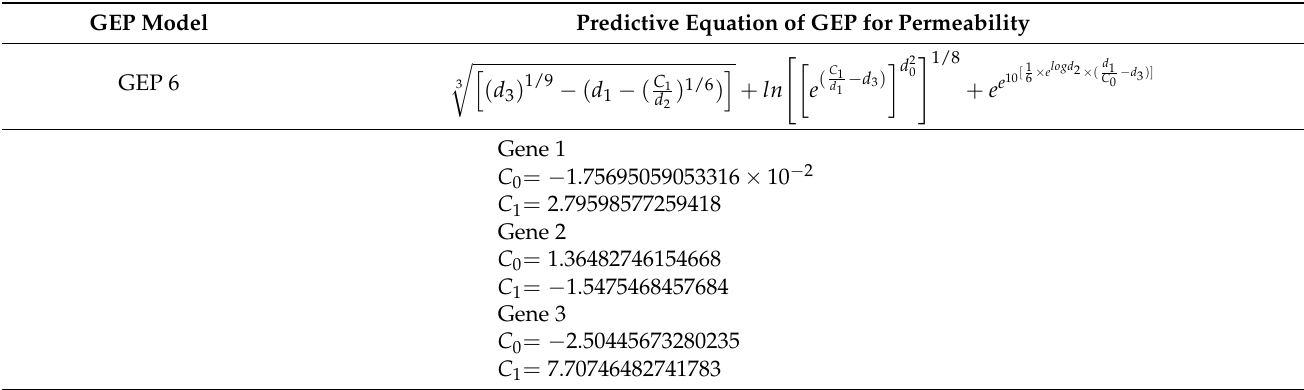
Table 10. The mathematical formulation of permeability of concrete samples containing nano-MgO proposed by the GEP